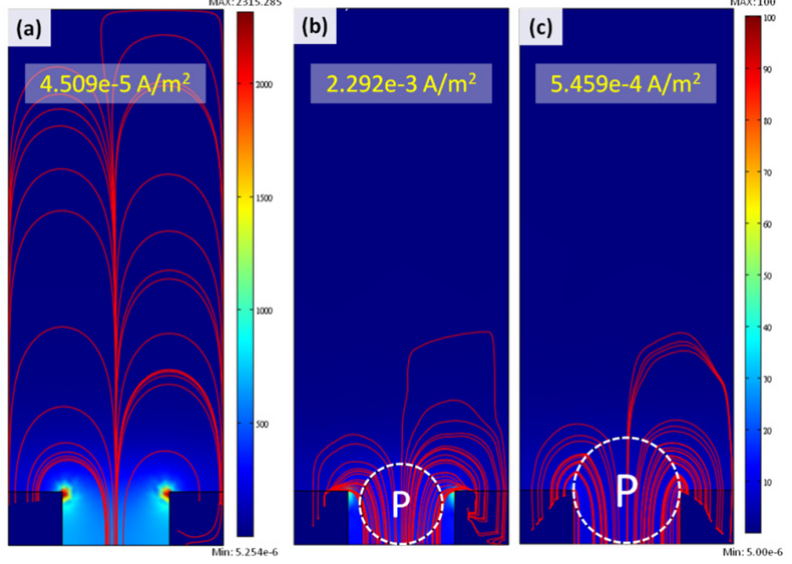
Figure 4. The distribution of current density as impedance measurement by applying voltage to middle and bottom electrodes; (a) without particle in the SU-8 cavity; (b) and (c) with 15 μ m and 20 μ m cell in the SU-8 cavity,